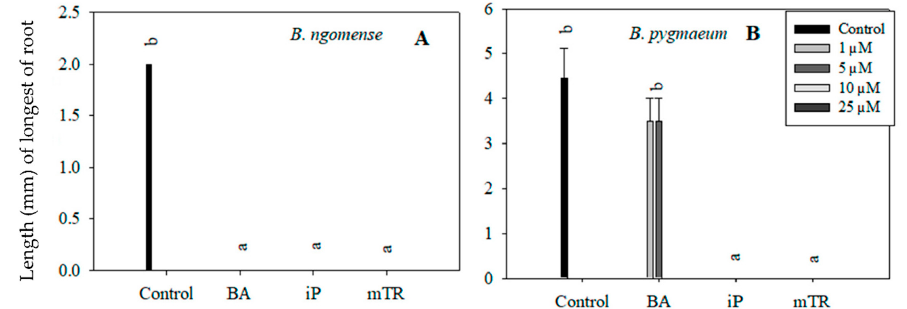
Figure 6. Effect of varying concentrations of cytokinins on the root length (mm) in ( A ) Brachystelma ngomense and ( B ) Brachystelma pygmaeum after six weeks in culture. In each graph, different letter(s) on the bars show significant differences according to Duncan’s multiple range test (DMRT) ( p ≤ 0.05). N 6 -benzyladenine (BA), isopentenyladenine (iP) and meta -topolin riboside ( m TR).